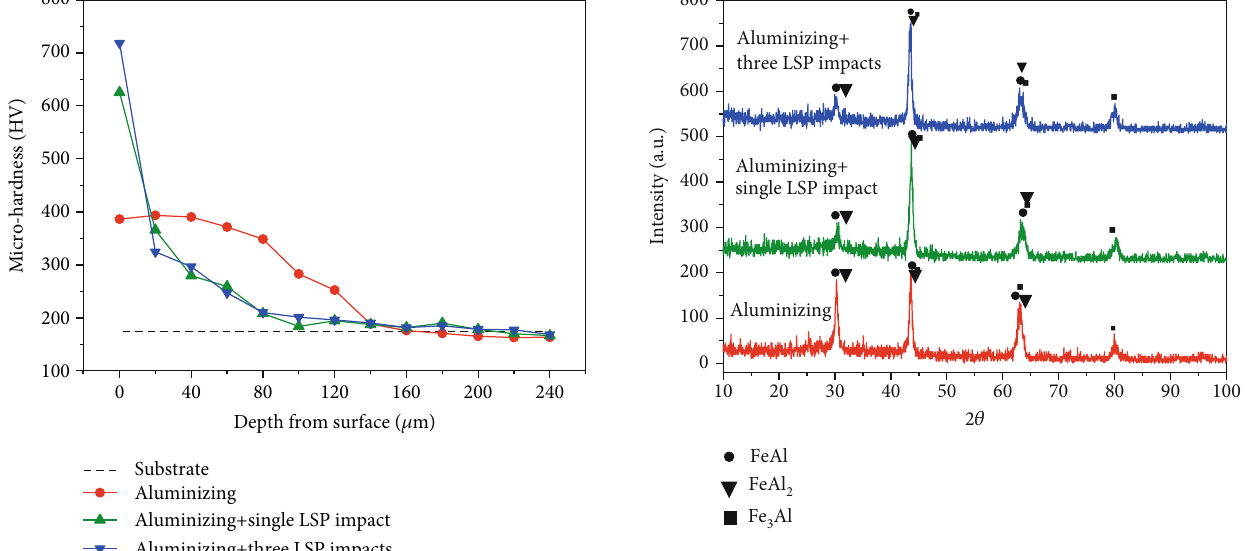
Figure 4: XRD spectra of the aluminized samples with di ff erent times of LSP